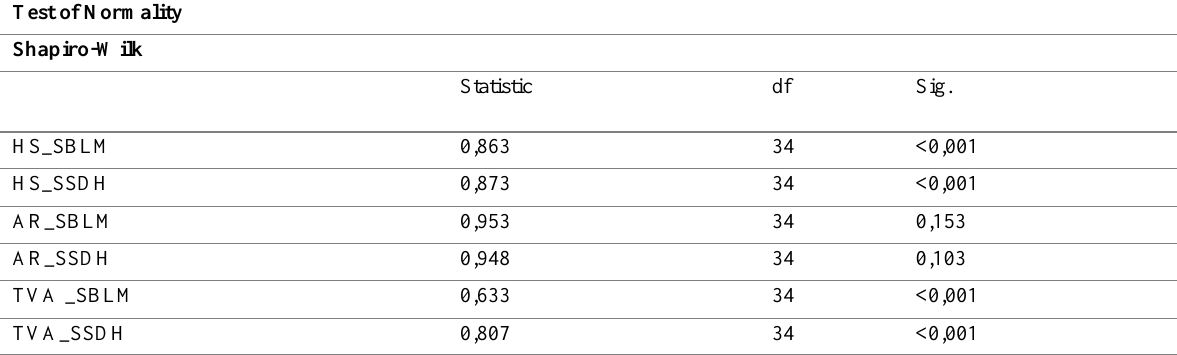
Table 5 : Normality Test